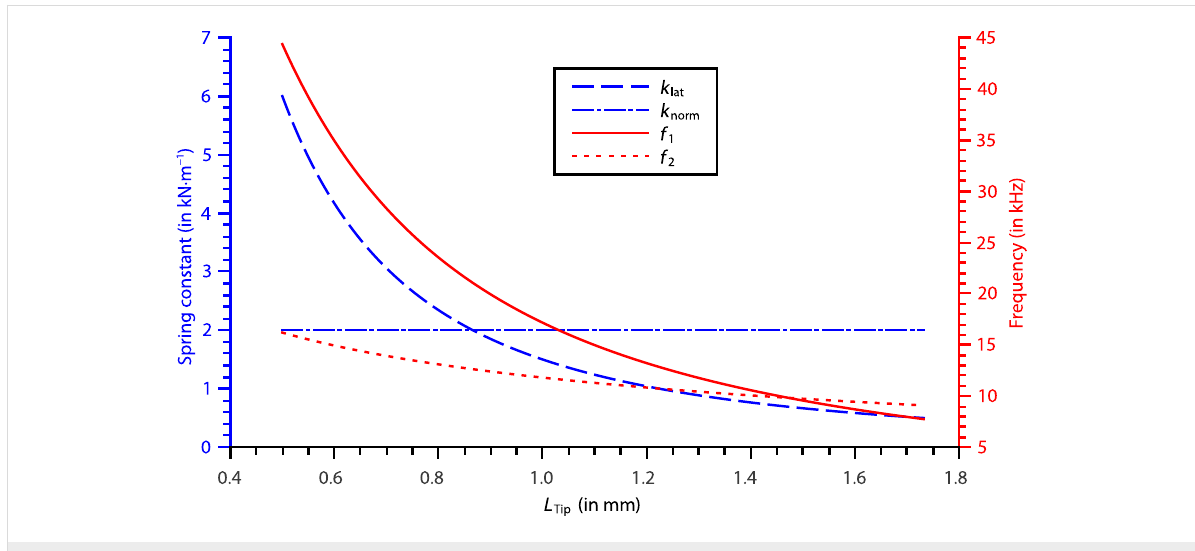
Figure 2: The effective spring constants ( k lat for mode 2, and k norm for mode 1) and eigenfrequencies of the first two eigenmodes of a symmetric sensor. Plotted for 150 μ m tungsten tips of varying